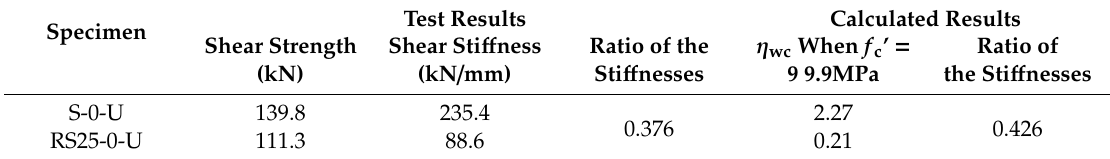
Table 5. Results of static tests on studs in